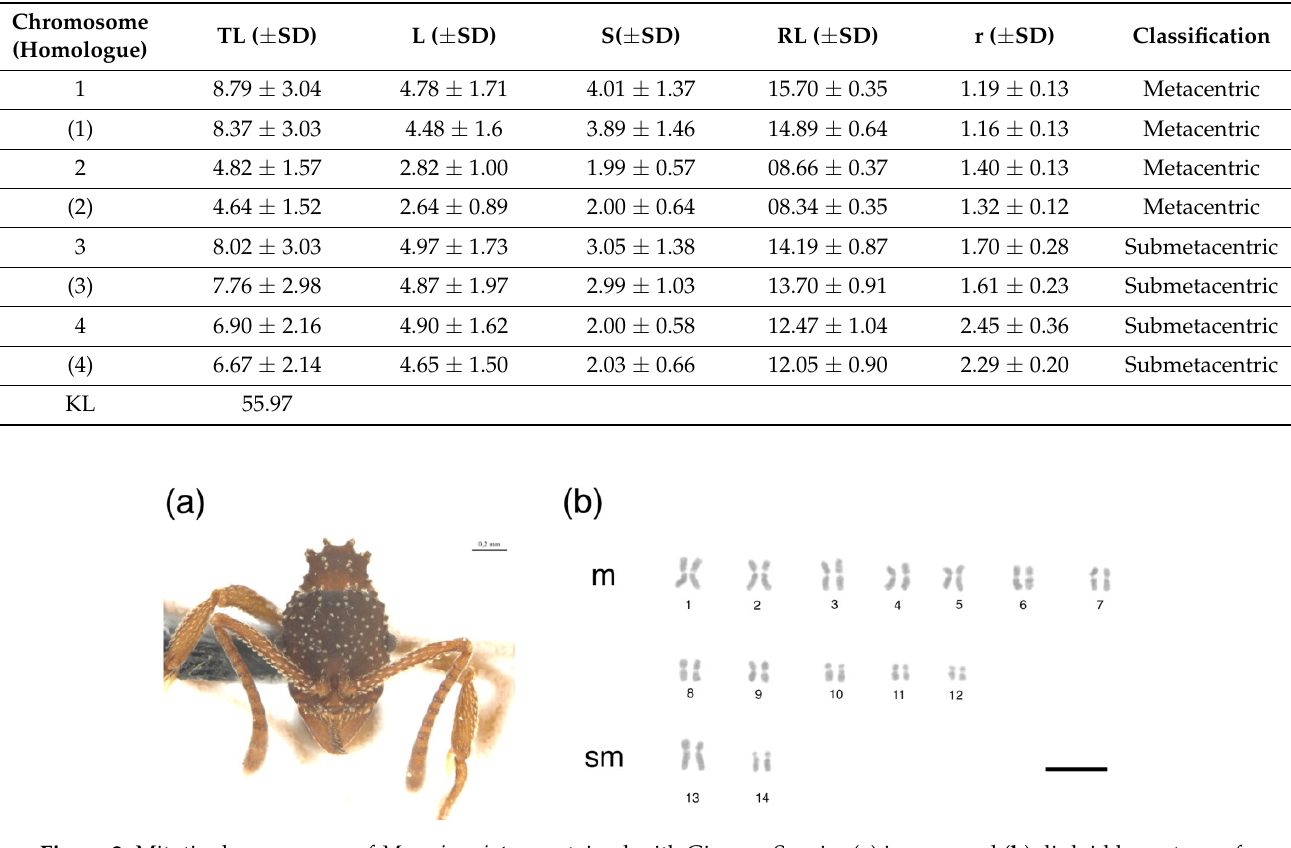
Figure 1. Mitotic chromosomes of Mycocepurus goeldii stained with Giemsa. Species ( a ) images and ( b ) diploid karyotype of Mycocepurus goeldii with 2 n = 8 chromosomes. m = metacentric, sm = submetacentric. Scale bar = 5 µ m. Ant image from Table 1. Karyomorphometric analyses of the chromosomes of Mycocepurus goeldii . All measurements are given in “ µ m”. TL: total length; L: long arm length; S: short arm length; RL: relative length; r: arm ratio; KL: karyotype length.